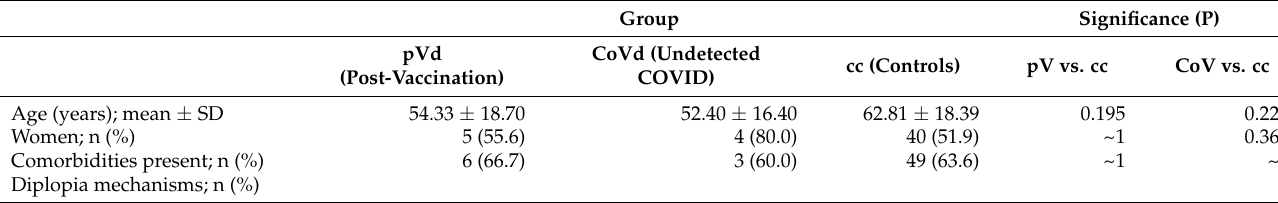
Table 1. The comparison of the three study groups. Group Significance